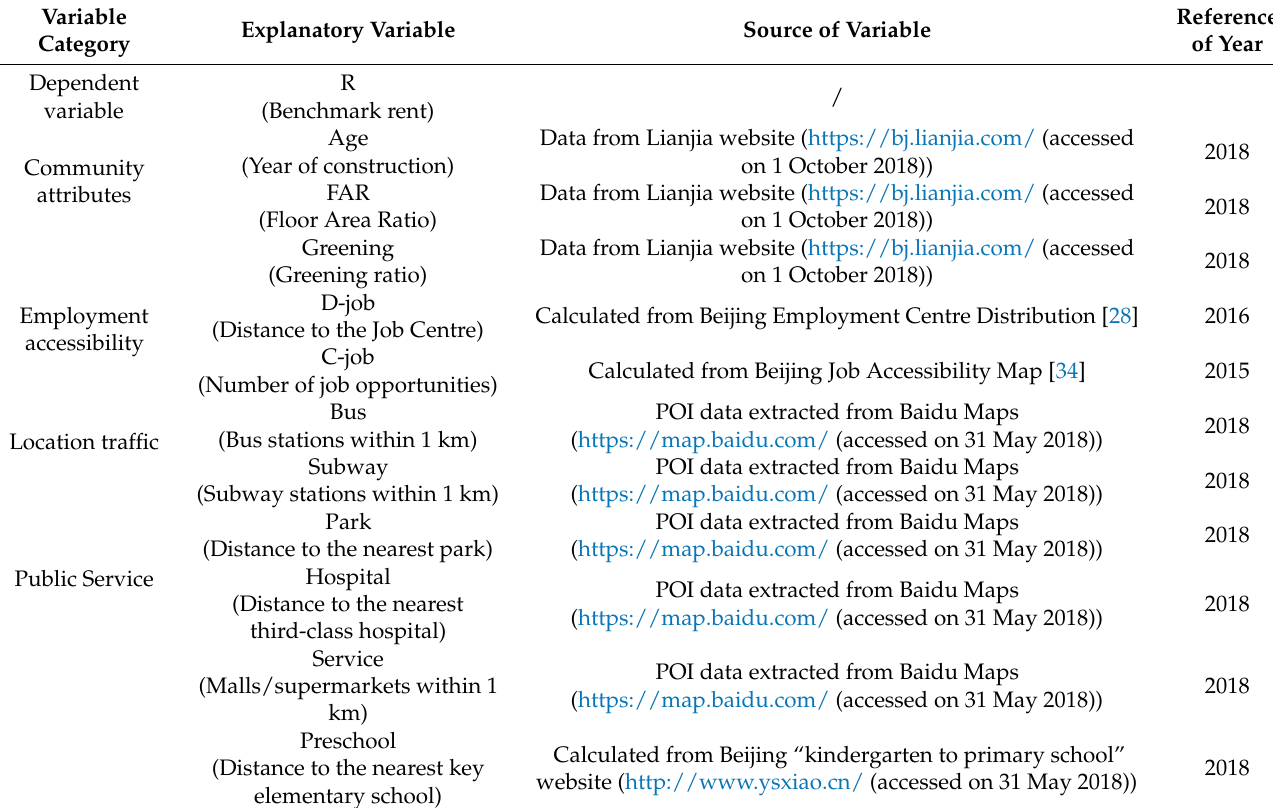
Figure 2. Employment opportunities within 60 min in Beijing. Table 2. Source for the Statistics of the